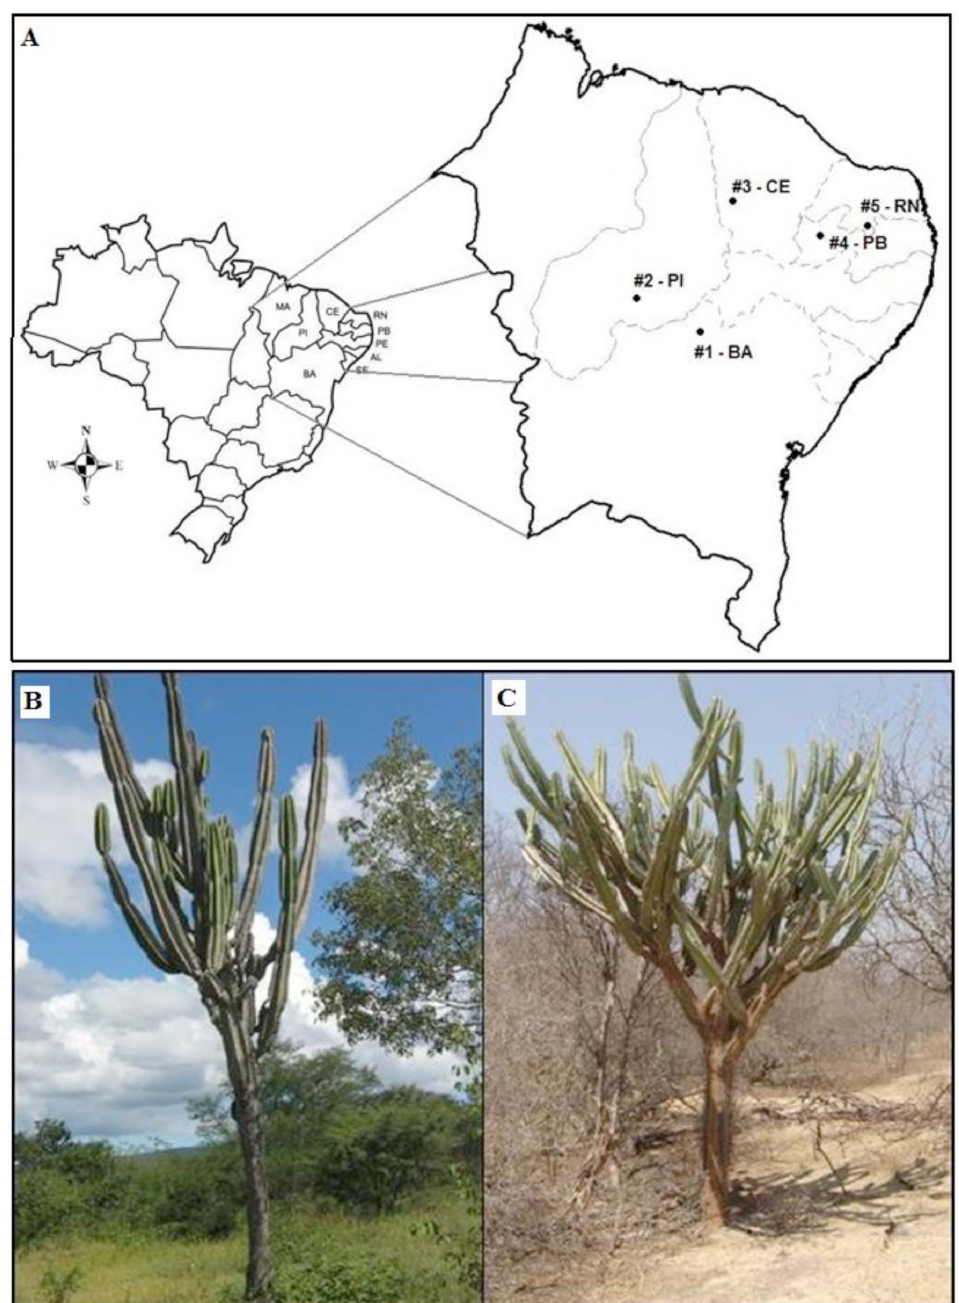
Figure 1. Sampling in the Caatinga biome in the semi-arid region of northeast Brazil. A - Map of Brazil in detail showing the distribution of the sampling sites comprising five states ( # 1 - Bahia (BA), S09 u 13 9 24.8 99 ; W41 u 05 9 11.4 99 ; # 2 - Piauı´ (PI), S08 u 50 9 01.6 99 , W42 u 33 9 13.3 99 ; # 3 - Ceara´